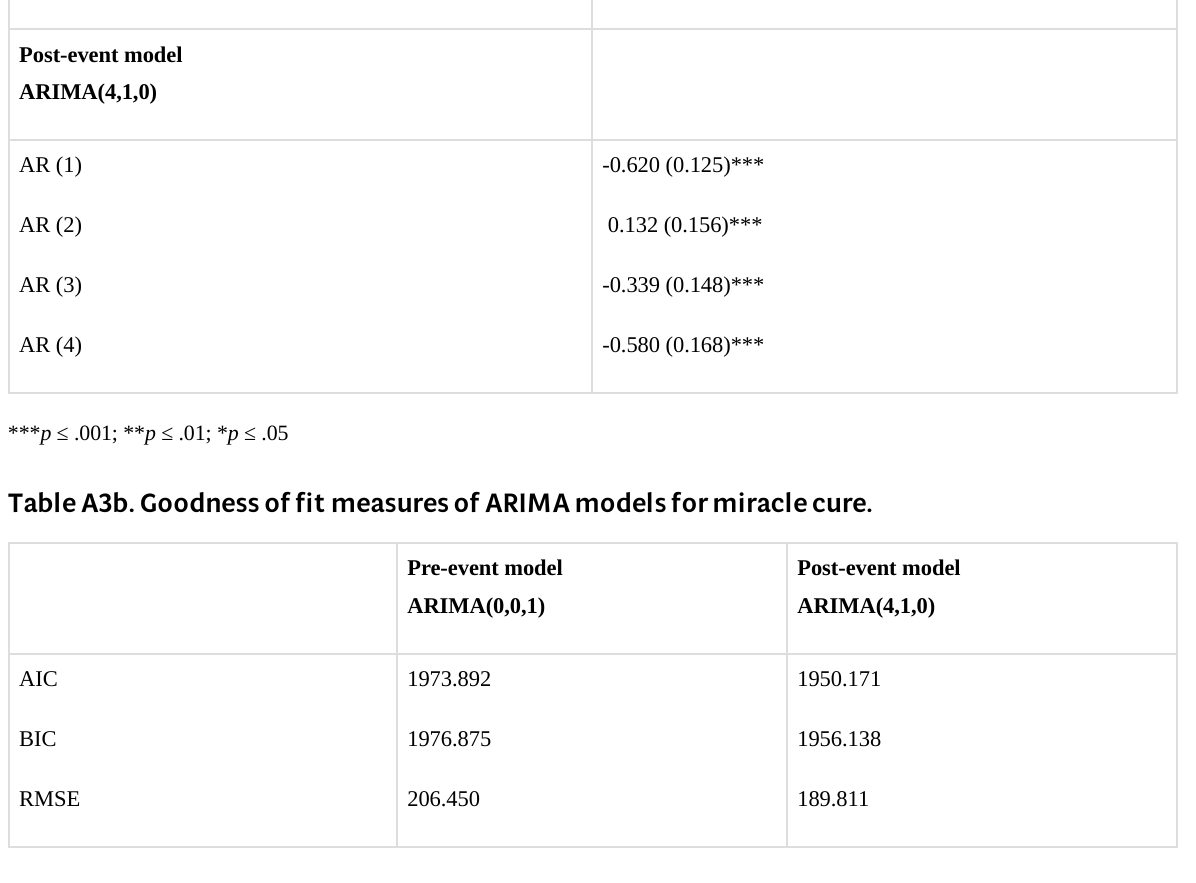
Table A4a. Parameter estimates of ARIMA models for border